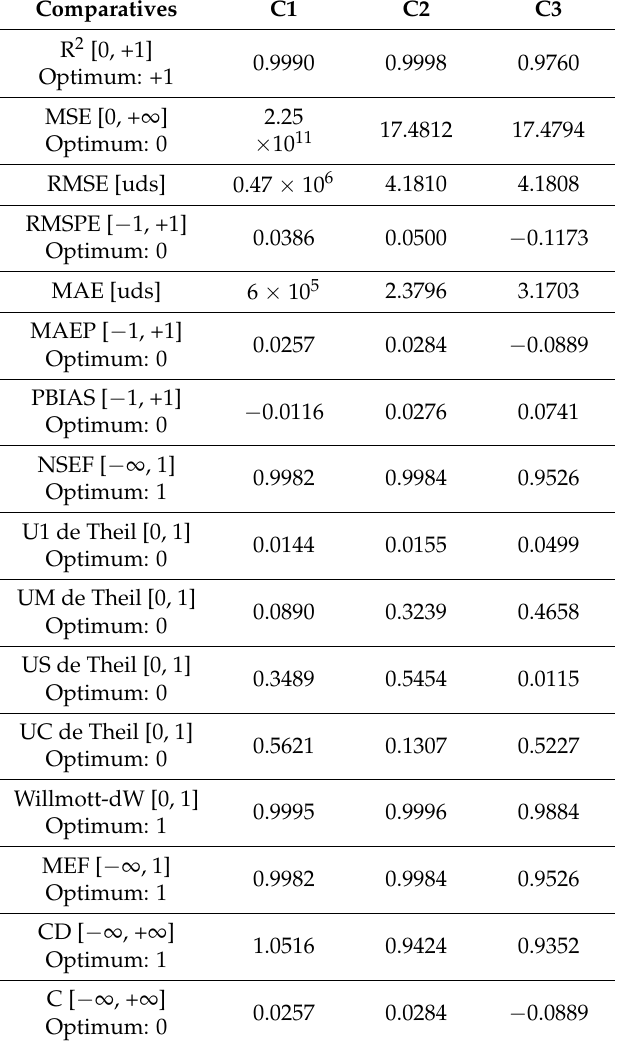
Table 2. Metrics of the comparisons proposed.